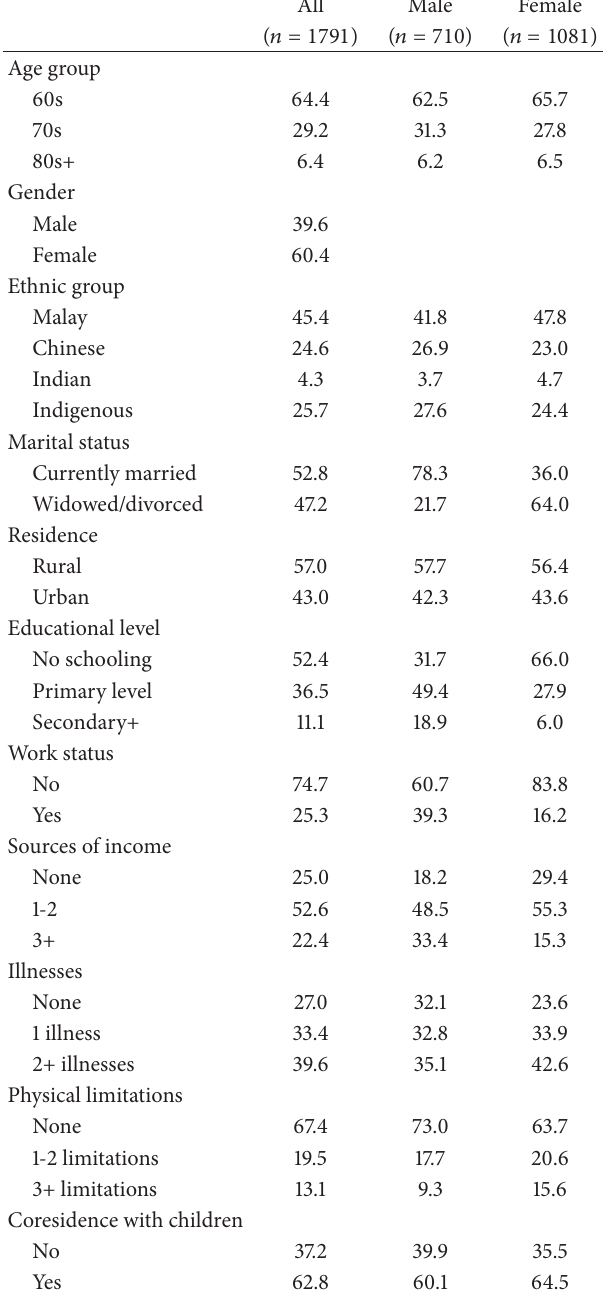
Table 1: Sociodemographic characteristics, health and disability, and coresidence status of respondents